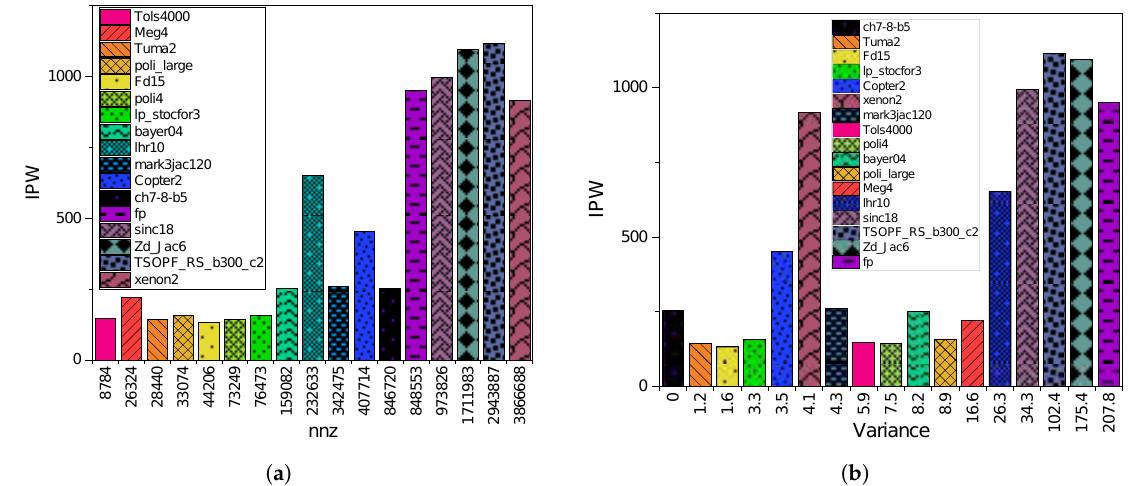
Figure 19. CSR5 instructions per warp (IPW) against: ( a ) nnz and ( b ) npr variance .